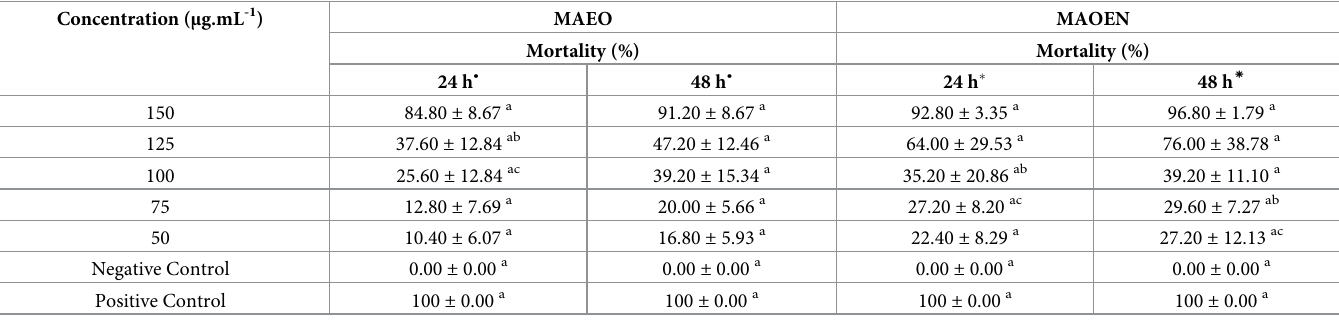
Means within a column with different letters are significantly different. Means within a row with different simbols are significantly different (p-value ˂ 0.001, F = 13,464).